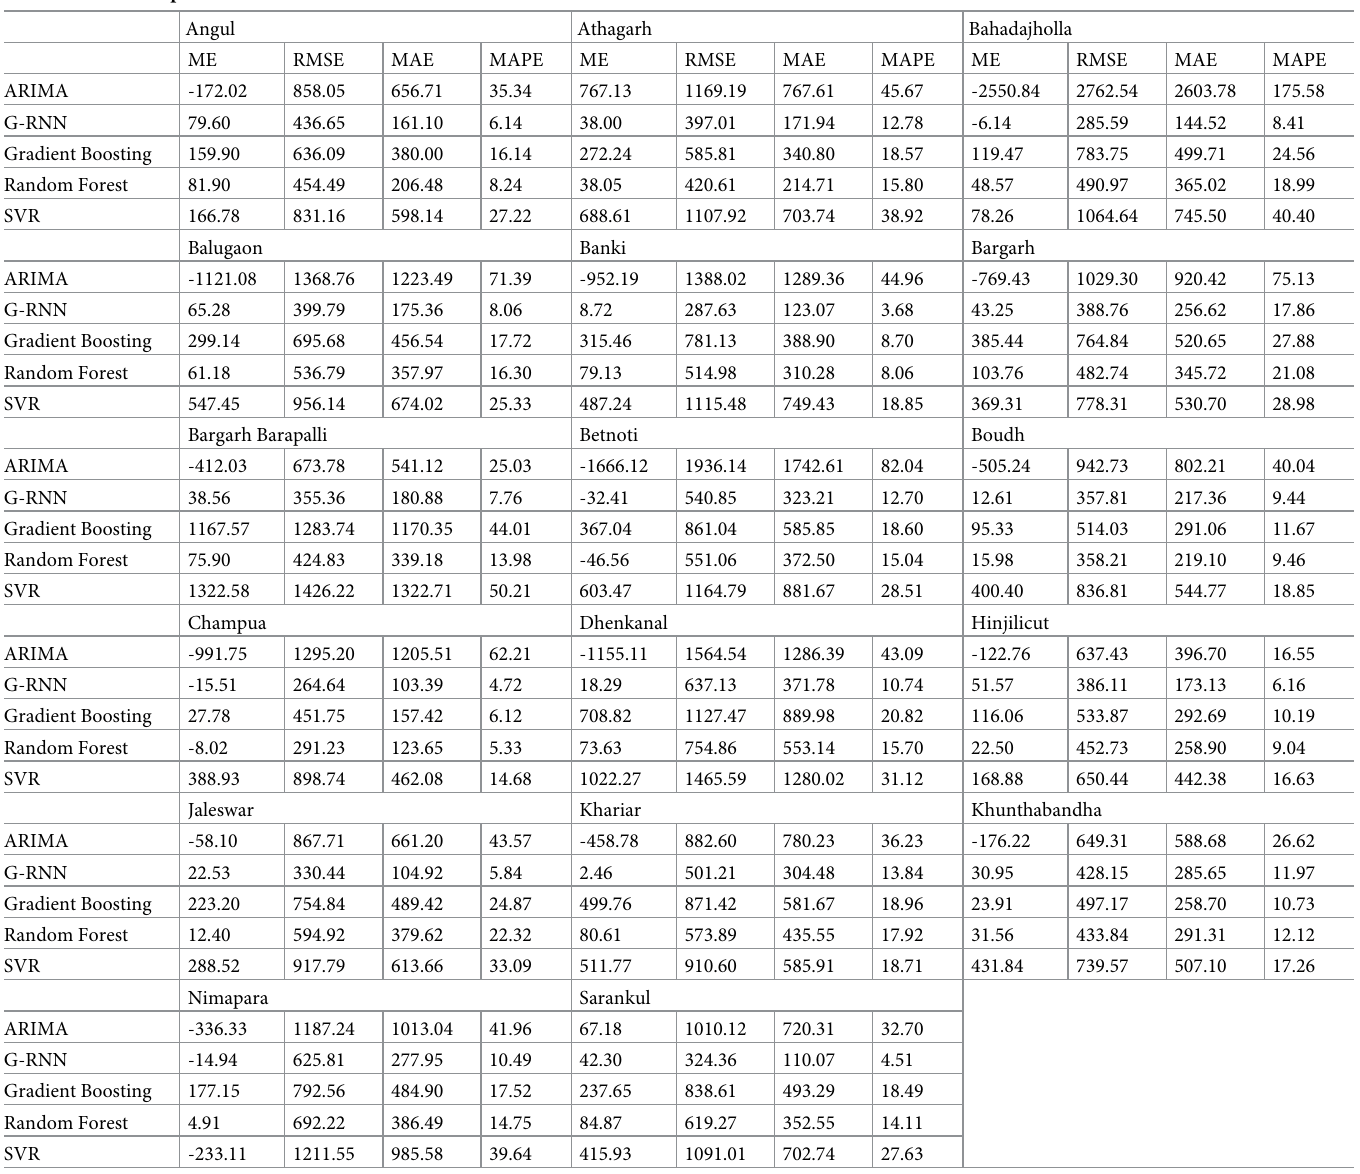
Table 4. Prediction performance of different